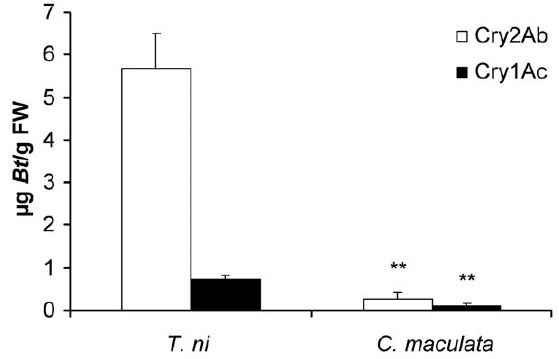
Figure 2. Concentrations (mean + SD) of Cry1Ac and Cry2Ab in larvae of Trichoplusiani and Coleomegillamaculata (FW=fresh weight). 2nd instar larvae of Trichoplusia ni fed on BollGard II H cotton for 3 days, and the 2nd instar larvae of Coleomegilla maculata had fed Bt -cotton reared T. ni larvae for 3 days (based on fresh weigh). The asterisks ‘‘**’’ indicate the level of significance (P , 0.01) in the Cry protein (Cry2Ab or Cry1Ac) concentrations between T. ni and C. maculata .